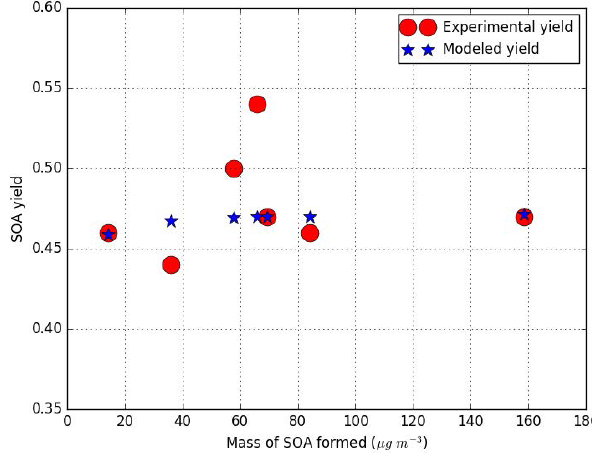
Figure 1. SOA yield from smog chamber experiments under low- NO x conditions (Yee et al., 2013; Chhabra et al., 2011; Nakao et al., 2011), and yield curve for phenol–OH reaction using one-product